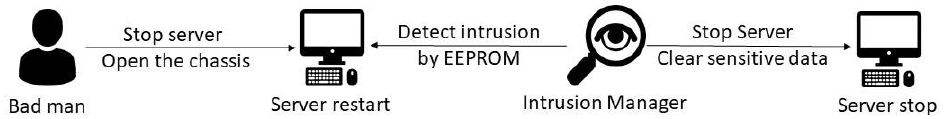
Figure 23. Diagram of the test case 2 process.